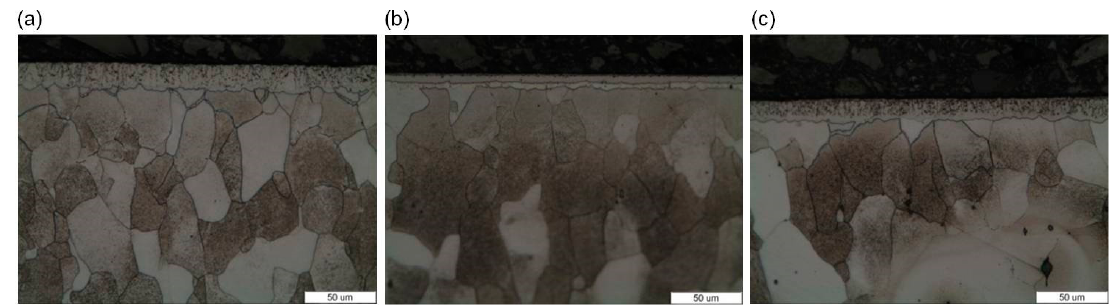
Figure 3. Cross-sectional OM images from the gas-nitrided pure iron with various nitriding potential: ( a ) 1.4, ( b ) 0.38 and ( c ) 1st stage: 1.4 and 2nd stage: 0.38 of nitriding potential at 570 °C for ( a ), ( b ) 4 h and ( c ) 1st stage: 4 h and 2nd stage: 2 h.